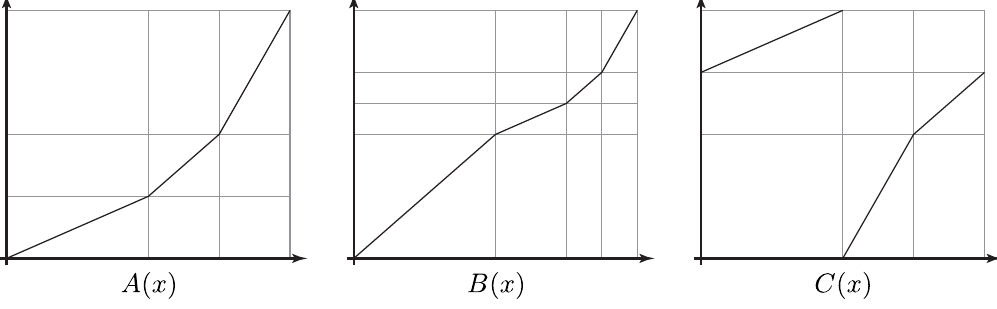
Figure 17 . The three generators of Thompson’s group T . A and B together generate Thompson’s group F